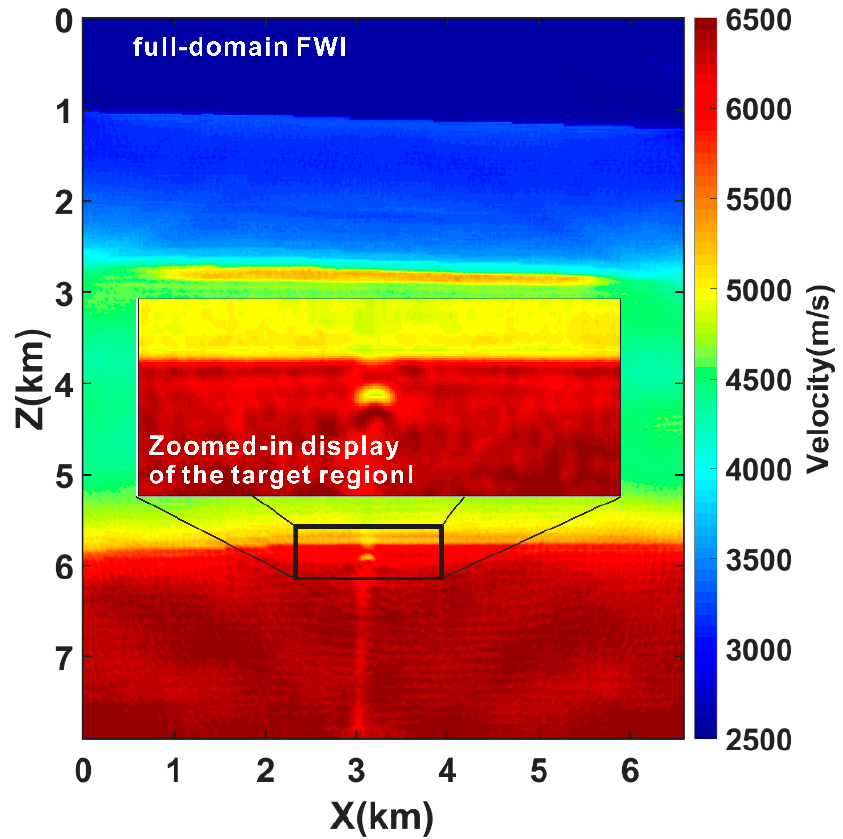
Figure 12. The inversion result of conventional full-domain FWI.